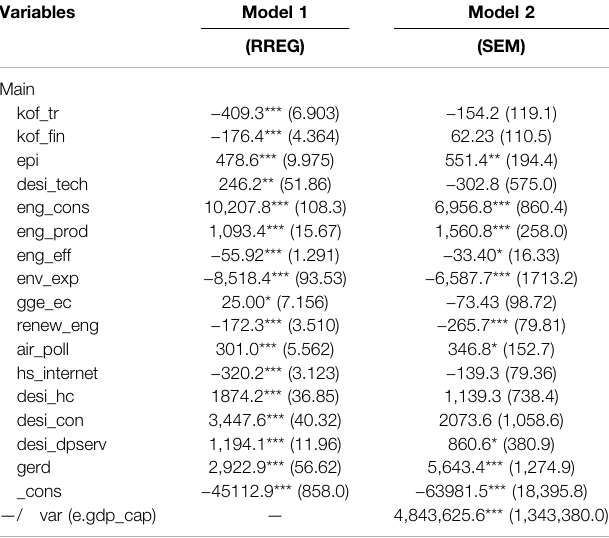
TABLE 2 | Results of robust regression models (RREG) and structural equations models (SEM) — dependent variable GDP per capita.